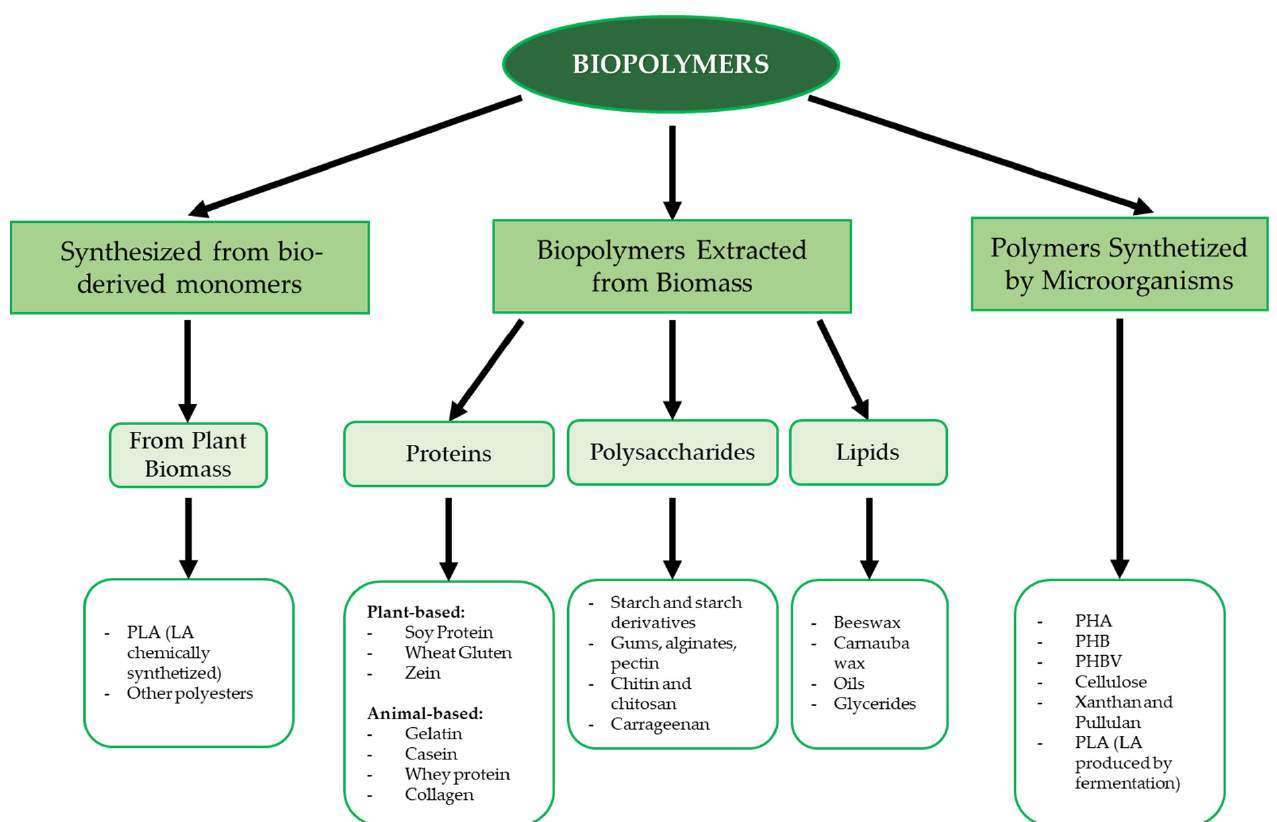
Figure 1. Schematic description of the main biopolymer classes. Abbreviations: PLA (polylactic acid), PHA (polyhydroxy alkanoate), PHB (polyhydroxy butyrate), PHBV (polyhydroxy butyrate-valerate).